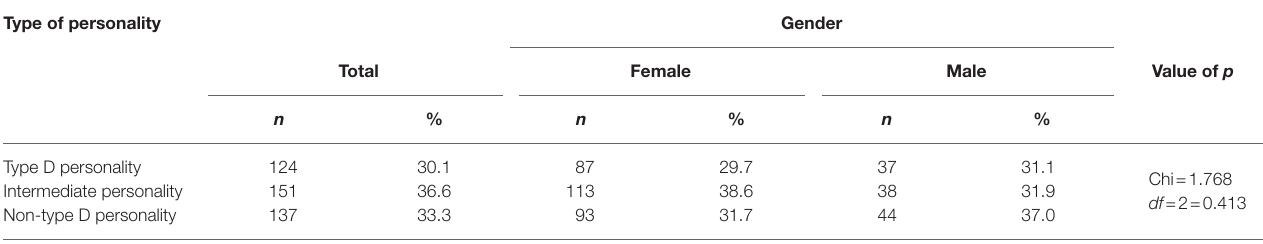
TABLE 2 | Type of personality among respondents.